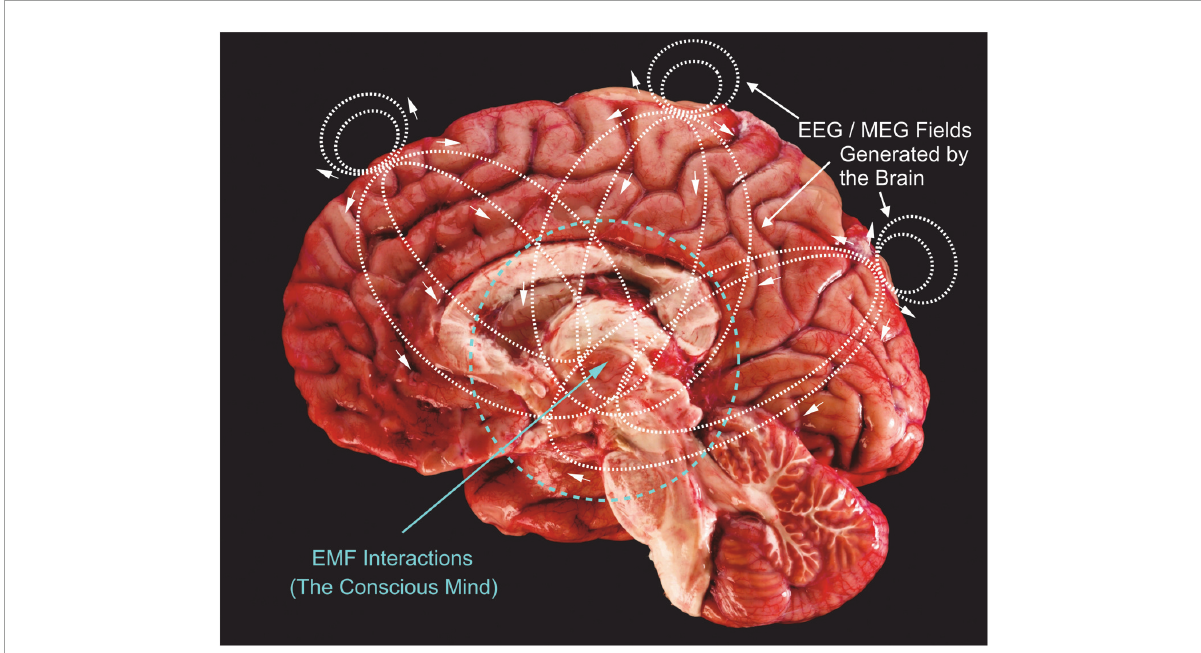
FIGURE2 Three current sources (e.g., synaptic ion channels) located in upper cortical layers of frontal, midline and occipital areas are shown, together with the charge paths they would produce (dotted lines with small arrows). Synaptic currents are usually carried by positive charges (Na + and Ca ++ ) that enter cells across dendritic membranes, so current lines show negative charge movement. These charge paths flow bidirectionally to produce fields above the cortex; these are what we measure with EEG surface electrodes. There are also charge paths directed inward, toward the thalamus and brainstem regions. Inward directed charge pathways would extend further because they are propagating through an electrolytic media that is not impeded by the dura and skull. I propose that these current paths would be concentrated toward the center of brains and generate much stronger EMFs compared to outward directed fields. Brain image modified from